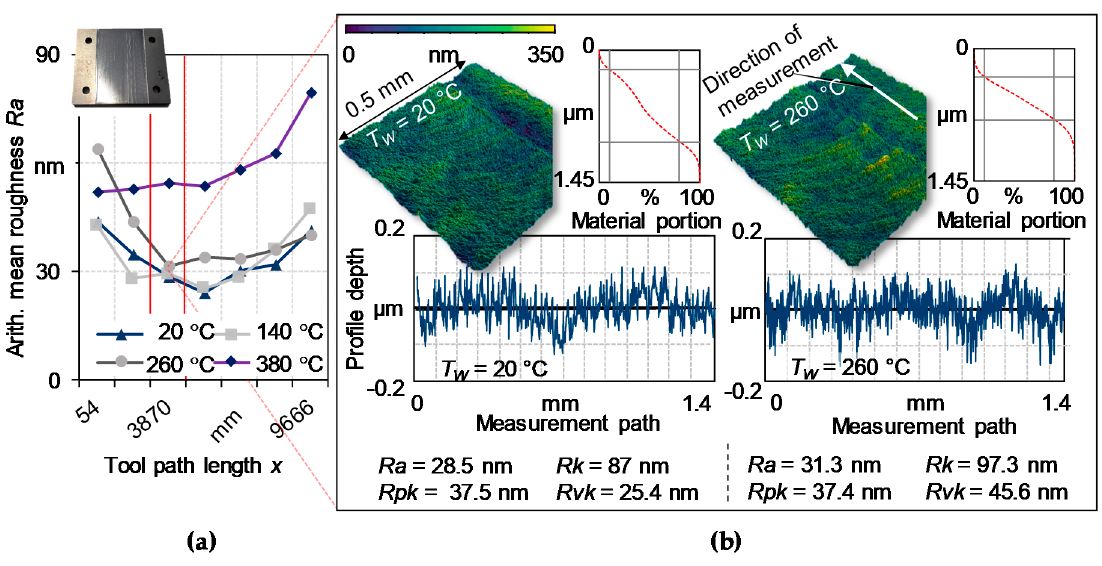
Figure 6. Top burr height h Burr by thermally assisted micromilling a HSS AISI M3:2. Thermally assisted processing at T W = 260 °C led to the lowest increase and thus to a reduction in the burr height h Burr up to 15.8 µm, i.e., by 49% on average. In addition to thermal softening, which appears to have a positive effect on the upper burr height h Burr , the associated tool wear has a strong influence on burr formation due to the amount of plastic deformed material in front of the dulled